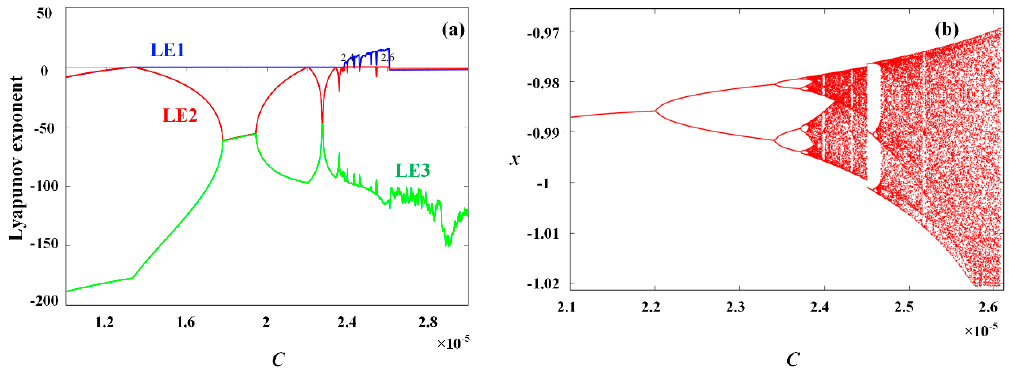
Figure 18. ( a ) Lyapunov exponent of the system, and ( b ) bifurcation of variable x with the capacitance C (if L = 0.96 H).